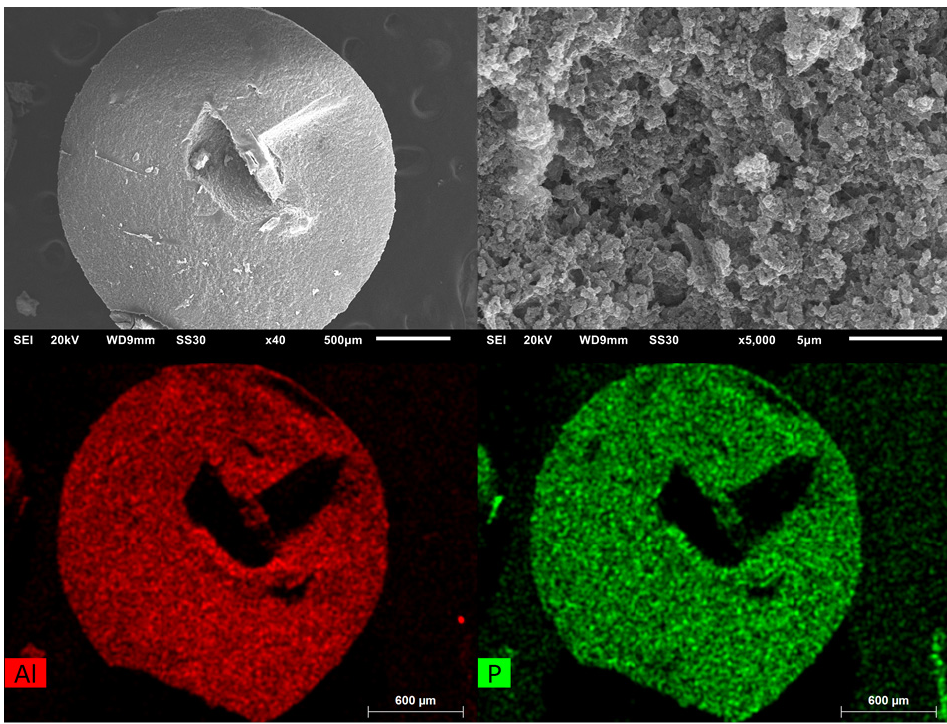
Figure 6. SEM images of Alfum80@chitosan at different magnifications (left: overview, right: close-up). EDX-element mapping for aluminum and phosphorus (bottom) for the particle in the overview at top left. The dark features in the element maps, that is, the lower amount of Al and P in the center and to the upper right of the bead are due to X-ray blocking by the groove in the bead surface so that the generated element-specific X-rays cannot be detected.